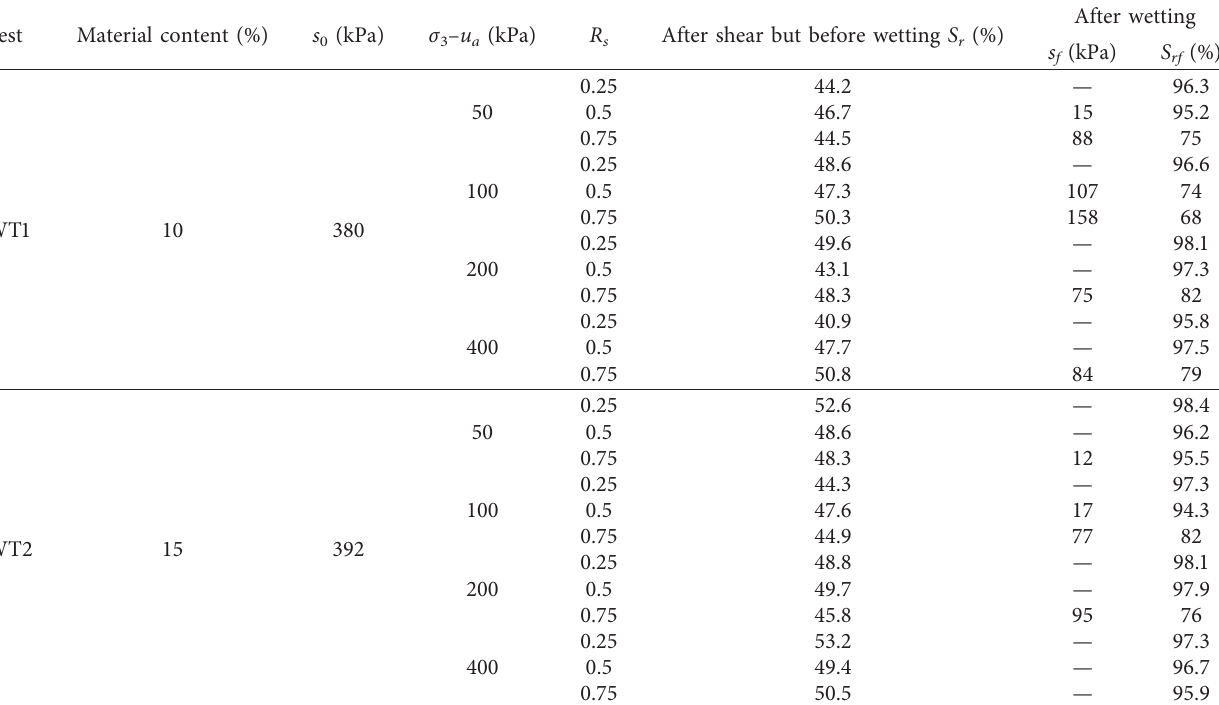
Table 4: Testing results of the WT